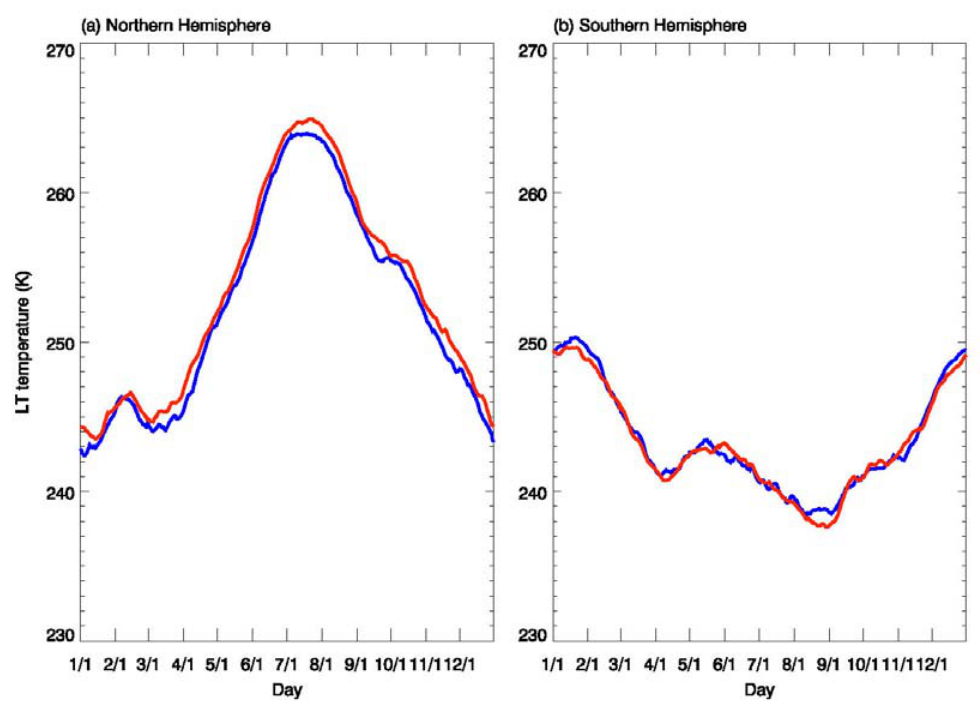
Figure 4. Average annual temperature cycles for Northern Hemisphere and Southern Hemisphere polar latitudes (60° to 82.5°) for an early period (1980–1989) and a later period (2000–2009). The blue line is for the early period and the red line is for the later